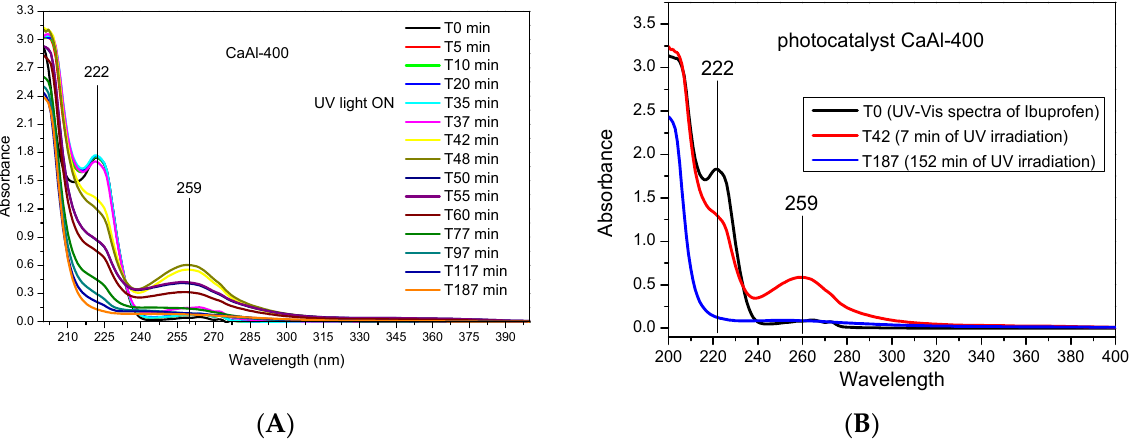
Figure 11. Ultraviolet-visible spectra of samples taken at different times when the CaAl-400 photo- catalyst was used. ( A ) UV–Vis spectra of all samples taken at different times; ( B ) UV–Vis spectra of ibuprofen (T 0 ), aliquot at T 42 and aliquot at T 187 .